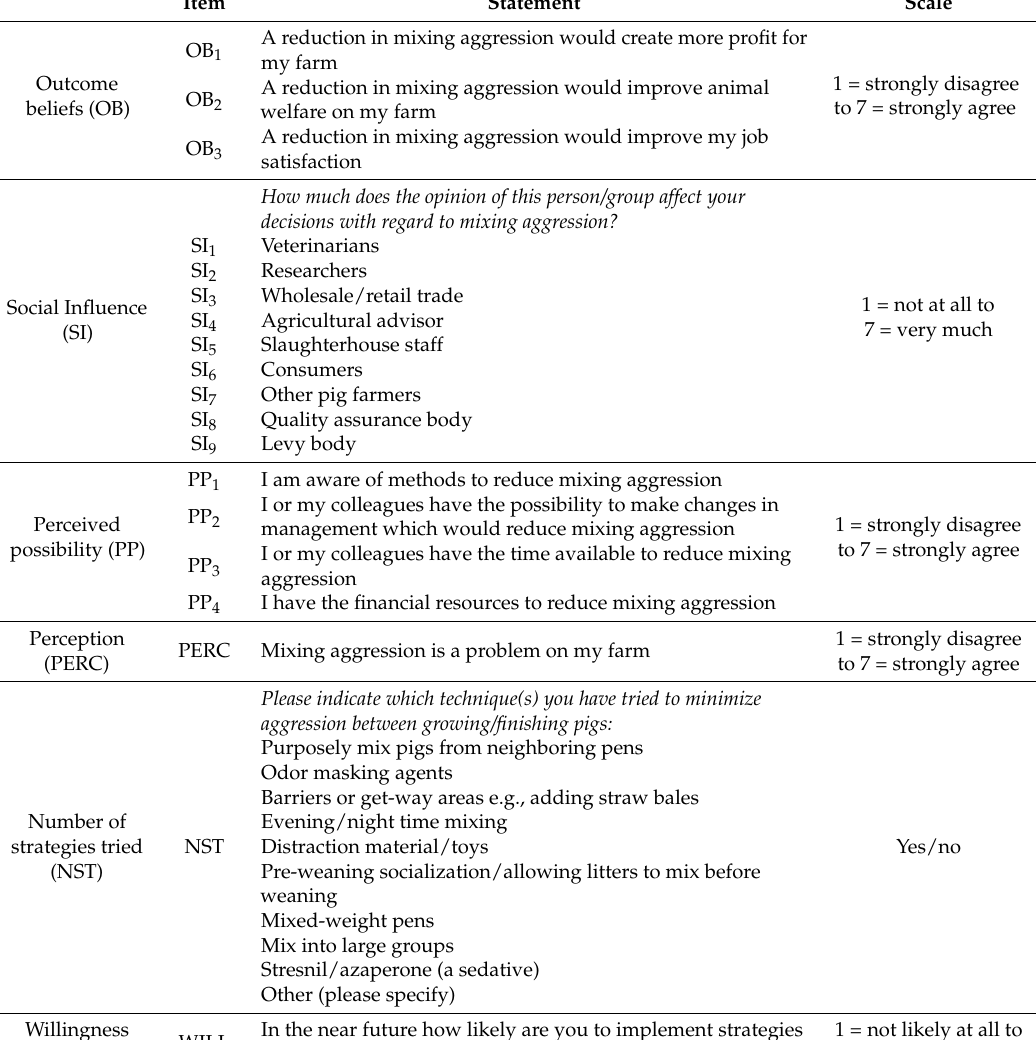
Table 1. Statements used to measure outcome beliefs about controlling aggression (OB), social influence (SI), perceived possibility to control aggression (PP), total number of aggression control strategies tried (NST), perception of aggression as a problem (PERC) and willingness to control aggression